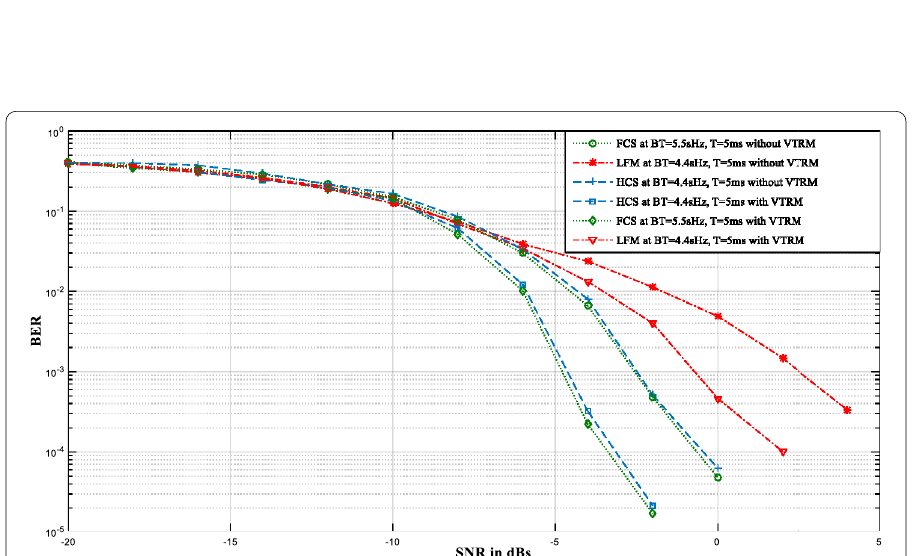
Fig. 14 BER versus SNR graph of HCS Chirp, FCS Chirp and LFM with SF 4.4sHz and 5.5 respectively and Chirp Period 5 m